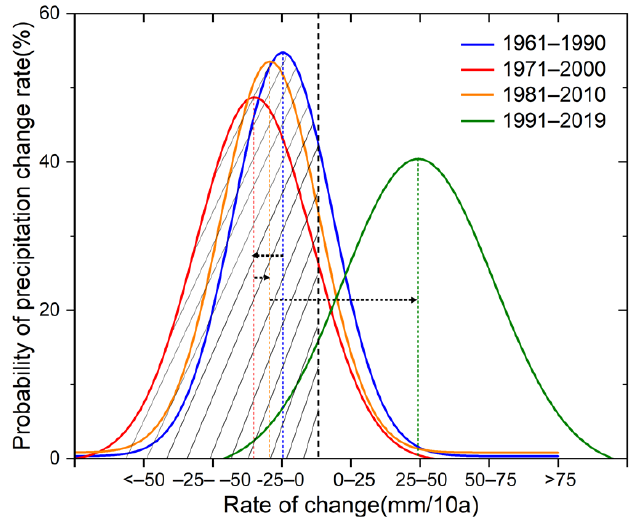
Figure 8. Probability distribution of annual precipitation change rate in different periods.